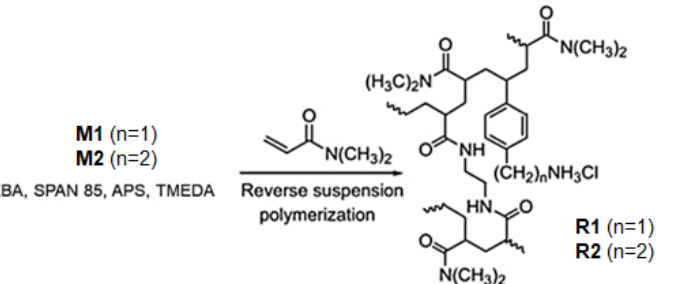
Scheme 1. Reverse suspension co-polymerization of M1 and M2 to achieve R1 and R2, respectively. Numbers 1 and 2 indicate the number of carbon atoms of the chain linking the styrene ring and the ammonium group in M1, M2, as well as in R1,